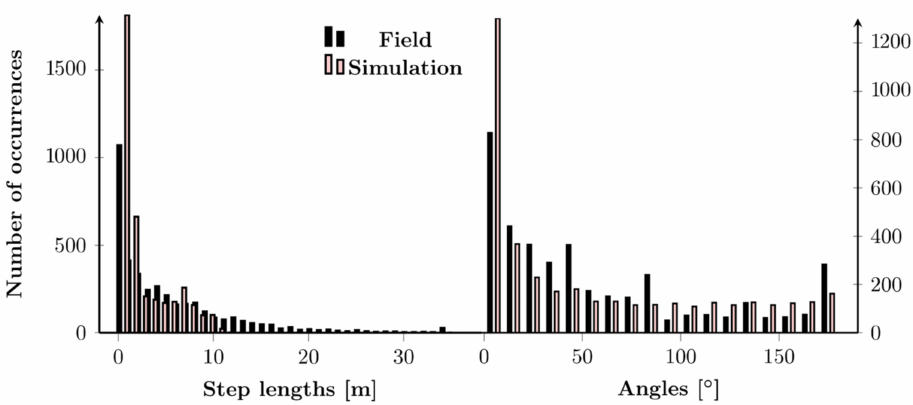
Figure 10. Histogram of step lengths ( left ) and angles ( right ) for field (black) and simulation (red) data during high food availability in the dry evergreen forest, with control parameters abundanceReach = 0.1, explorationZone = 2, velocity = 1 and levyRatio =